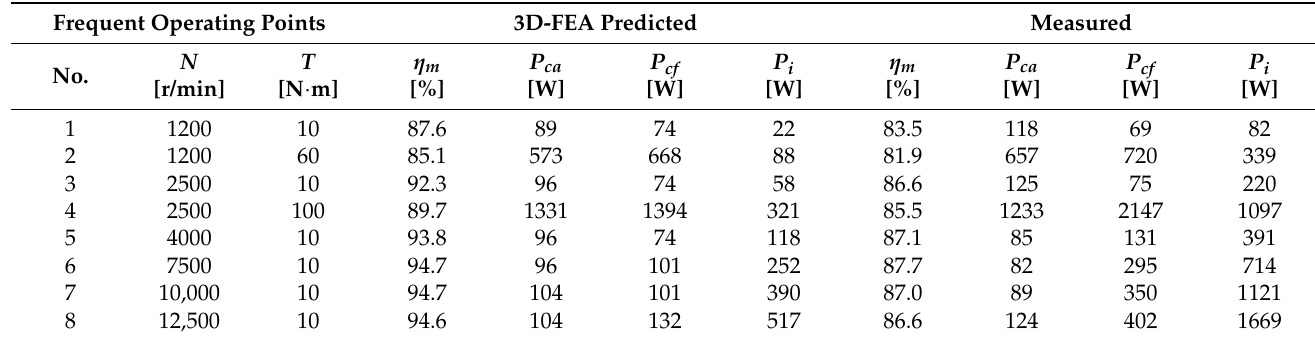
Table 2. 3D-FEA predicted and measured efficiency and loss analysis of the conventional HEFSM at frequent operating points.